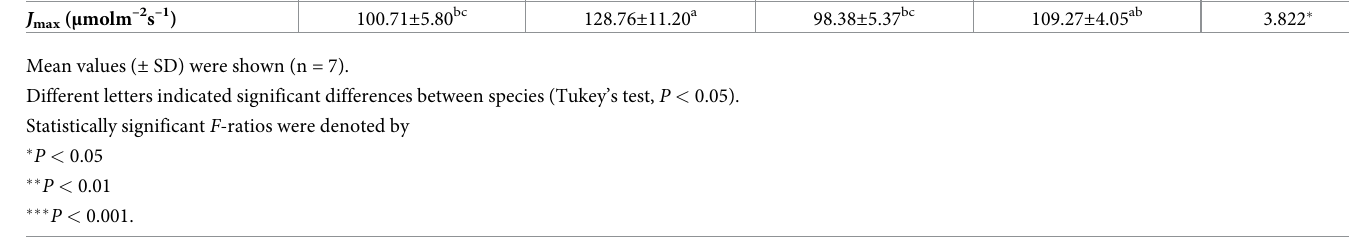
Table 3. Maximum carboxylation rate ( V cmax ) and maximum electron transport rate ( J max ) in four species seedling leaves. Leaf traits